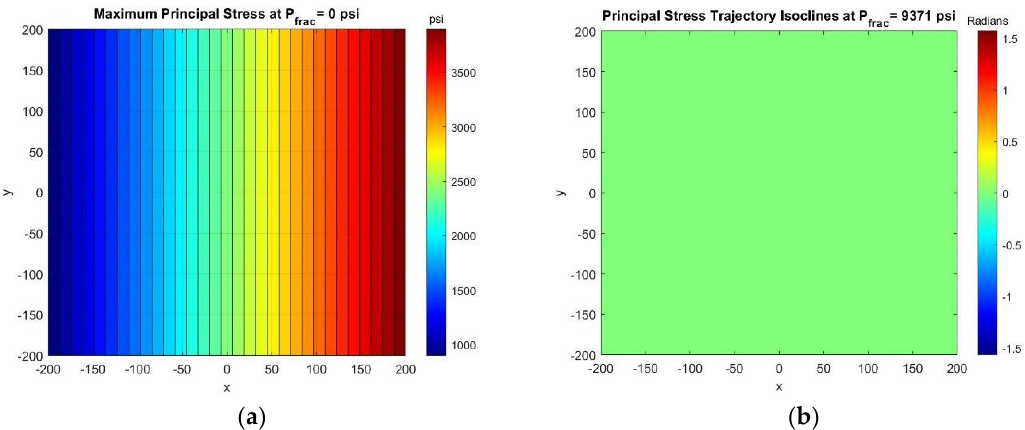
Figure 10. Initial pre-hydraulic fracturing TLSM model results for ( a ) magnitude of pore pressure values (psi), and ( b ) no principal stress trajectory isoclines occur at t = 0 s.